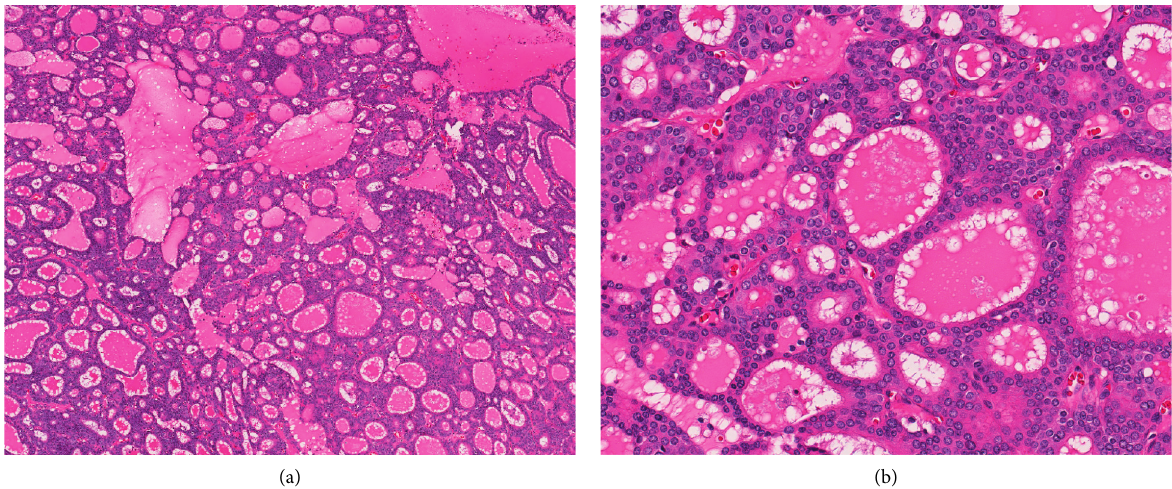
Figure 4: Sheets of tumour cells arranged in cystically dilated glands (a) that contain brightly eosinophilic secretions reminiscent of colloid (b).